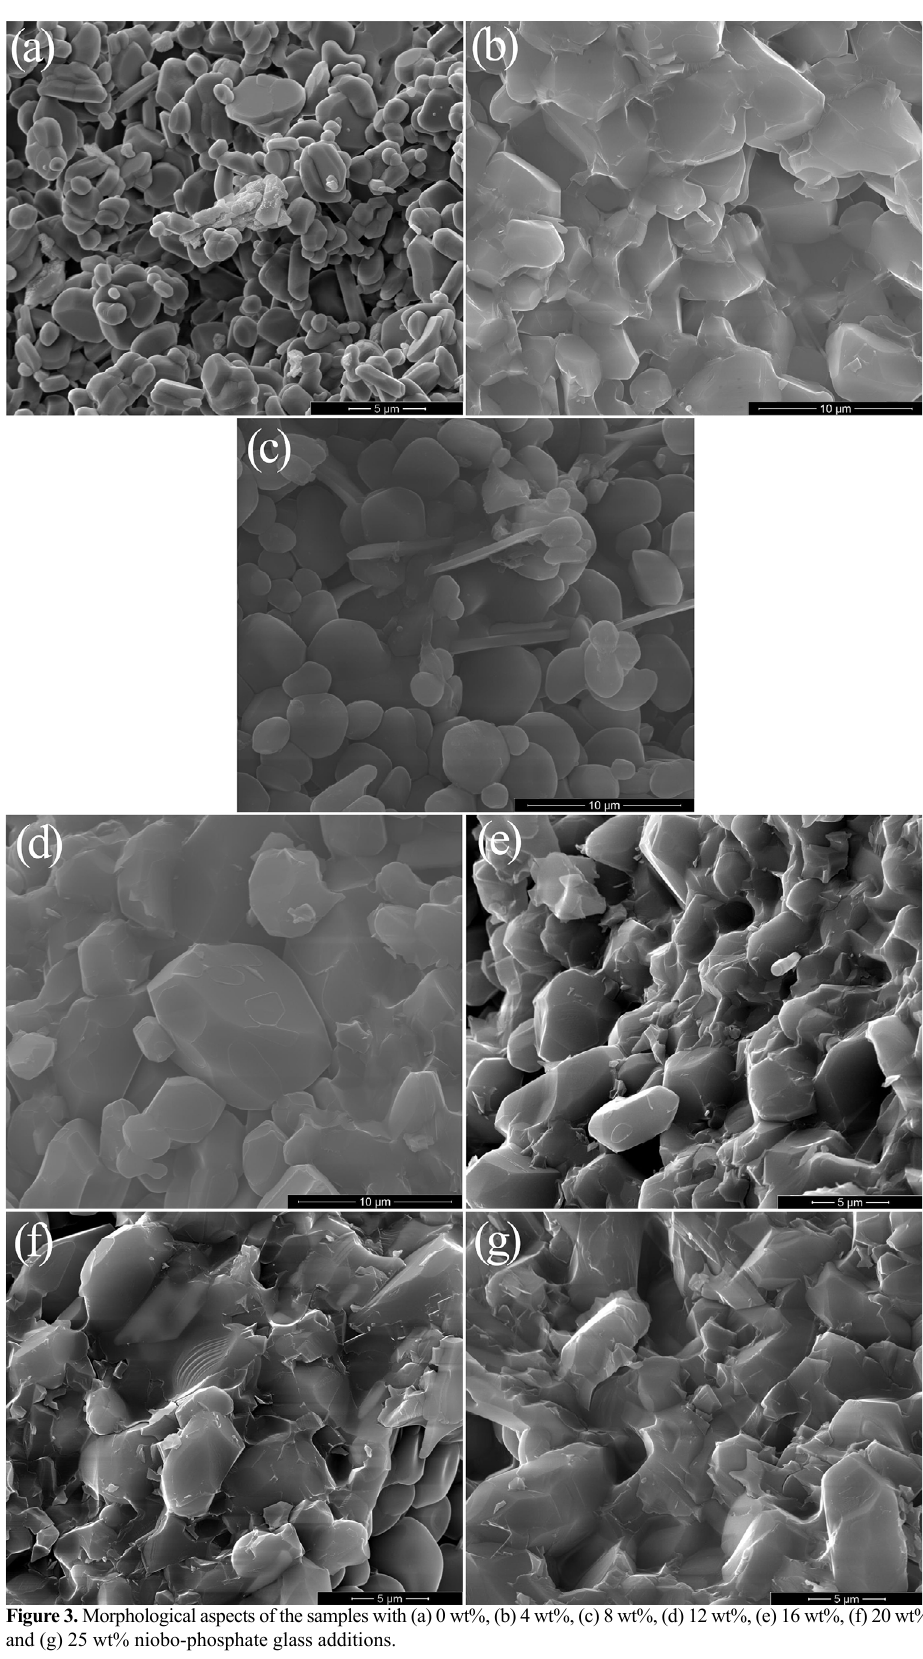
Figure 3. Morphological aspects of the samples with (a) 0 wt%, (b) 4 wt%, (c) 8 wt%, (d) 12 wt%, (e) 16 wt%, (f) 20 wt% and (g) 25 wt% niobo-phosphate glass